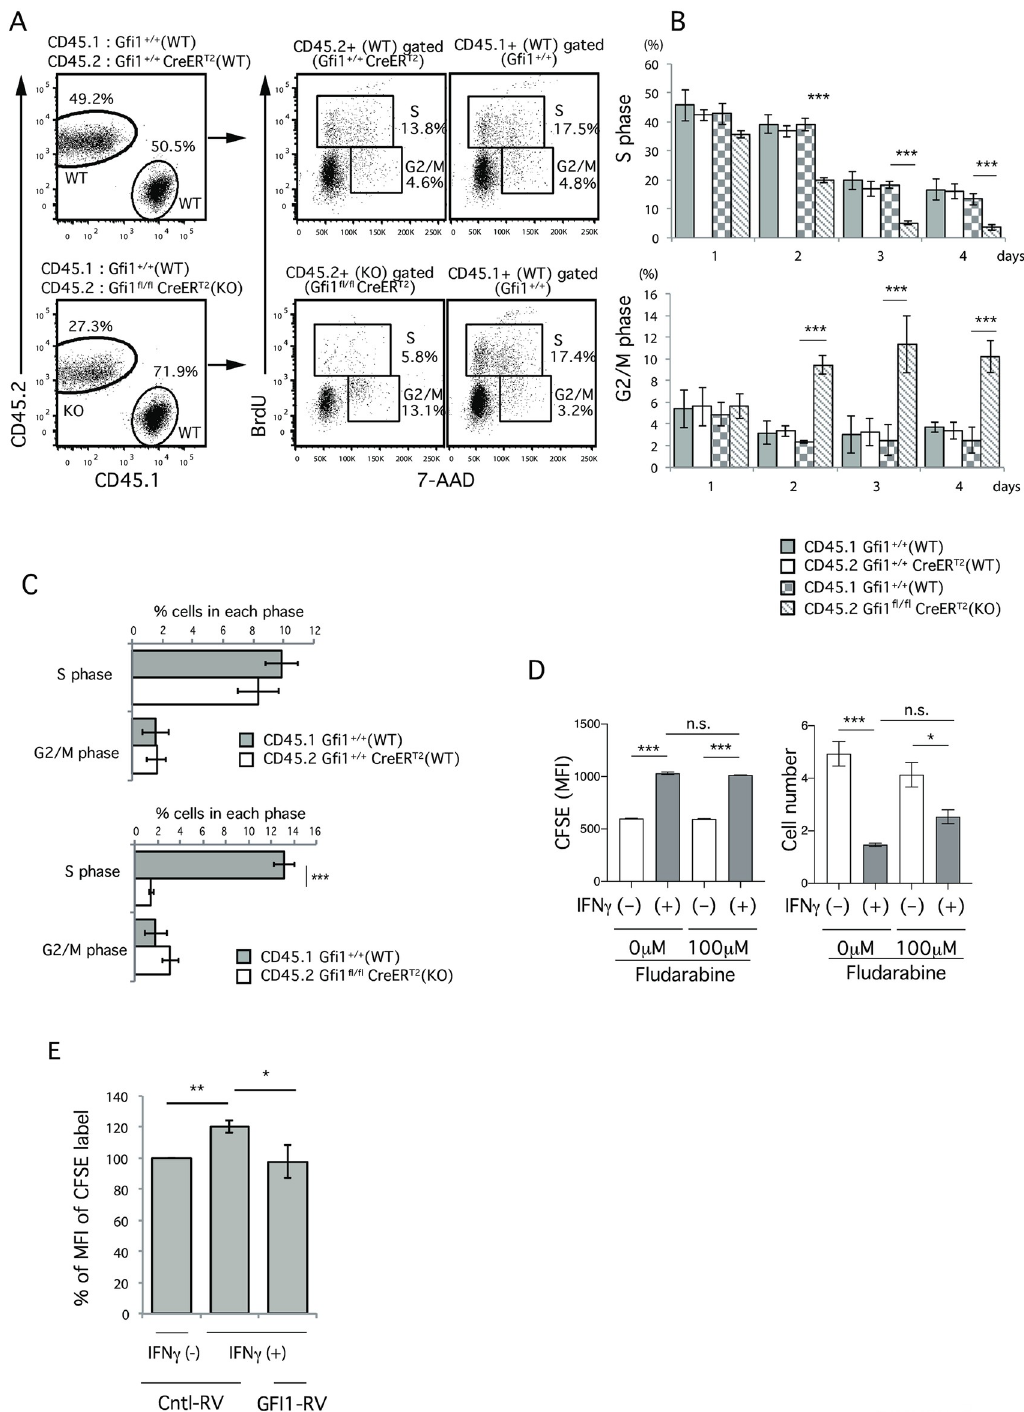
Fig 3. The loss of Gfi1 results in the blockade of G1/S, and the ectopic expression of GFI1 restores the IFN γ -mediated inhibition of Th2 cell proliferation. (A-C) The relative cell expansion of Gfi1 fl/fl CreER T2 (KO, CD45.2) or Gfi1 +/+ CreER T2 (WT, CD45.2) Th2 cells in comparison to CD45.1 WT Th2 cells on day 4 of culturing in the presence of IFN γ was determined (A, left). A cell cycle analysis was performed after gating of the indicated cell populations (A, right). The percentages of cells in the S phase or G2/M phase after gating of the indicated cell populations are shown (B). The percentages of cells in S phase or G2/ M phase of the indicated cell populations without the gating of CD45.1 or CD45.2+ cells (i.e., % in the culture) on day 3 (C). (D)